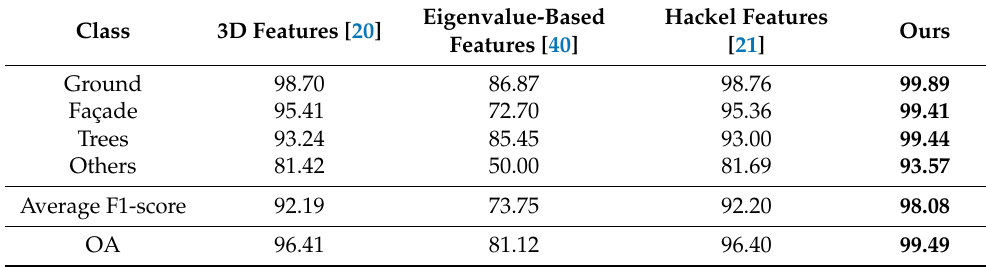
Table 8. F1-score (%) and OA (%) comparison with previous studies. Highest values are bolded. Eigenvalue-Based Class 3D Features [20] Features